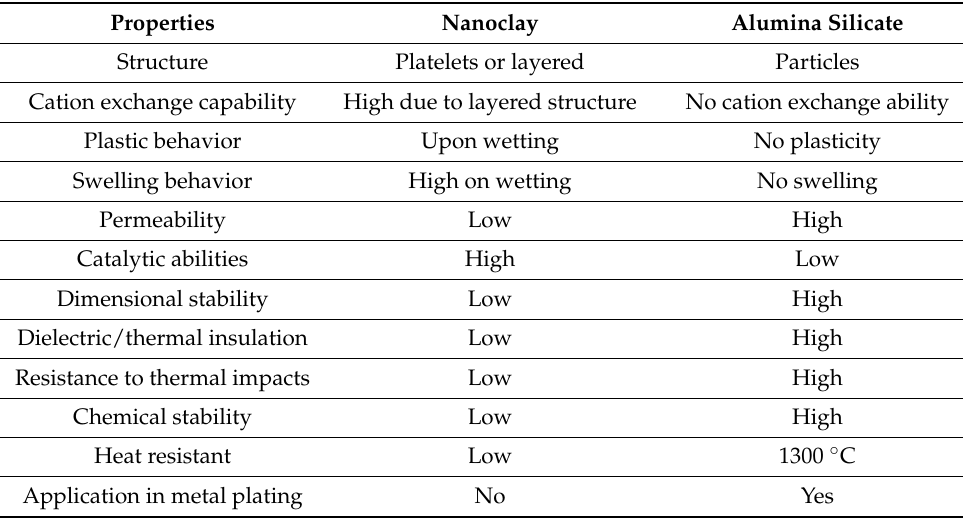
Figure 2. Entrapment of ions in layered nanosilicate nanostructure. Table 1. Comparative properties of nanoclays and alumina silicate particles.